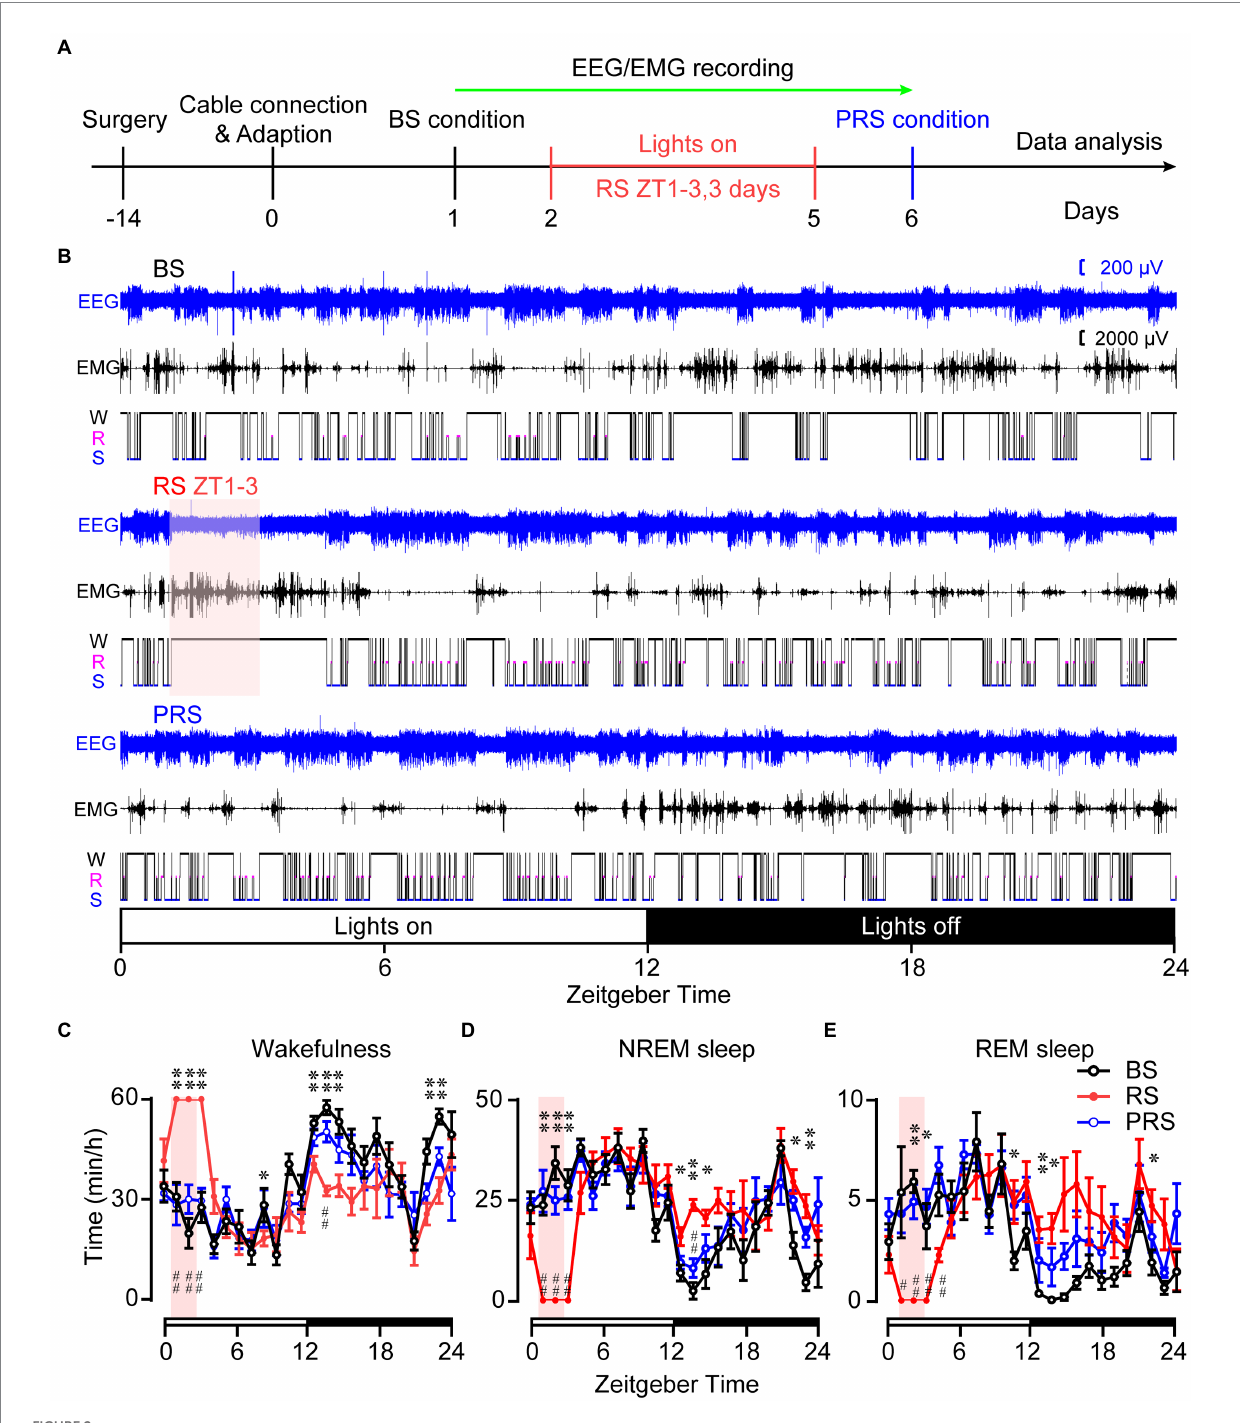
FIGURE 2 Time spent in the sleep–wake stages of the baseline, RS, and PRS conditions. Timeline and manipulations for conducting the sleep–wake recording. (A) Example of 24 h EEG/EMG traces and the corresponding hypnogram under the BS, RS, and PRS conditions. (B) Time spent in wakefulness (C) , NREM sleep (D) , and REM sleep (E) during a 24-h period. The pink box indicates restraint stress during 9:00–11:00. The open and closed bars above the X - axis indicate the light and dark periods, respectively. * p < 0.05, ** p < 0.01 versus baseline, # p < 0.05, ## p < 0.01 versus RS, n = 6. BS: baseline; RS: restraint stress; PRS: post-restraint stress; ZT: Zeitgeber